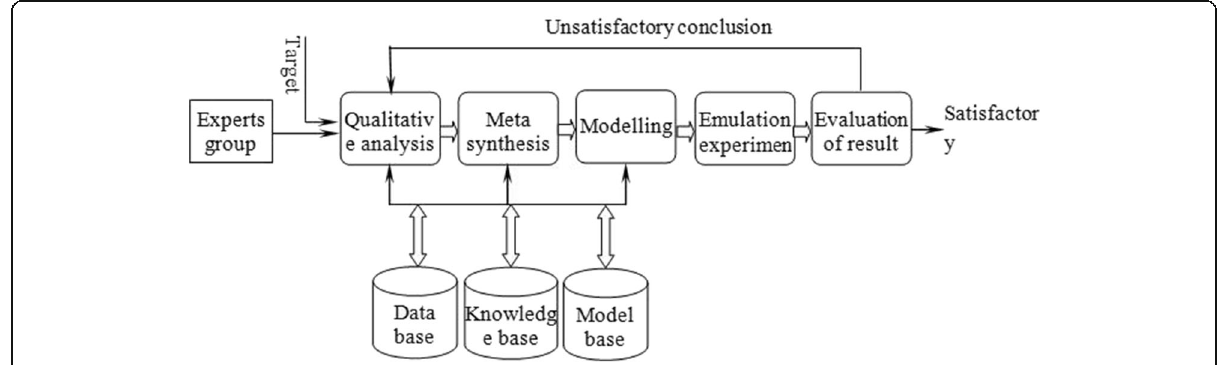
Fig. 1 Meta synthesis from qualitative to